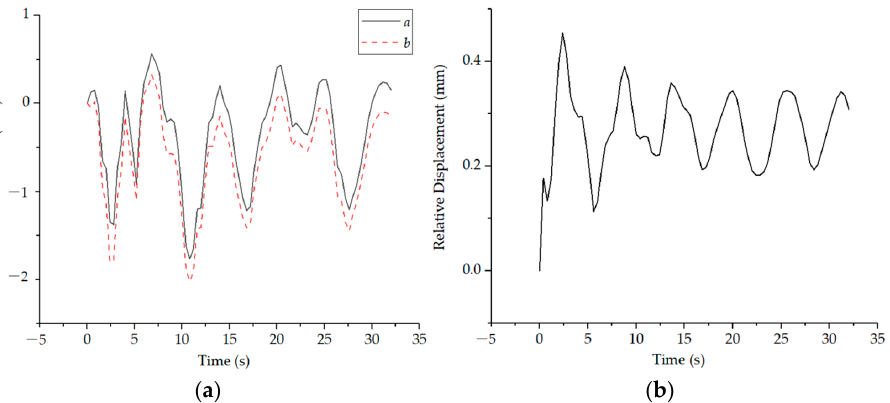
Figure 6. Output data curve of time and displacement: ( a ) Displacement change of point a and point b ; ( b ) Relative displacement of point a and point b .